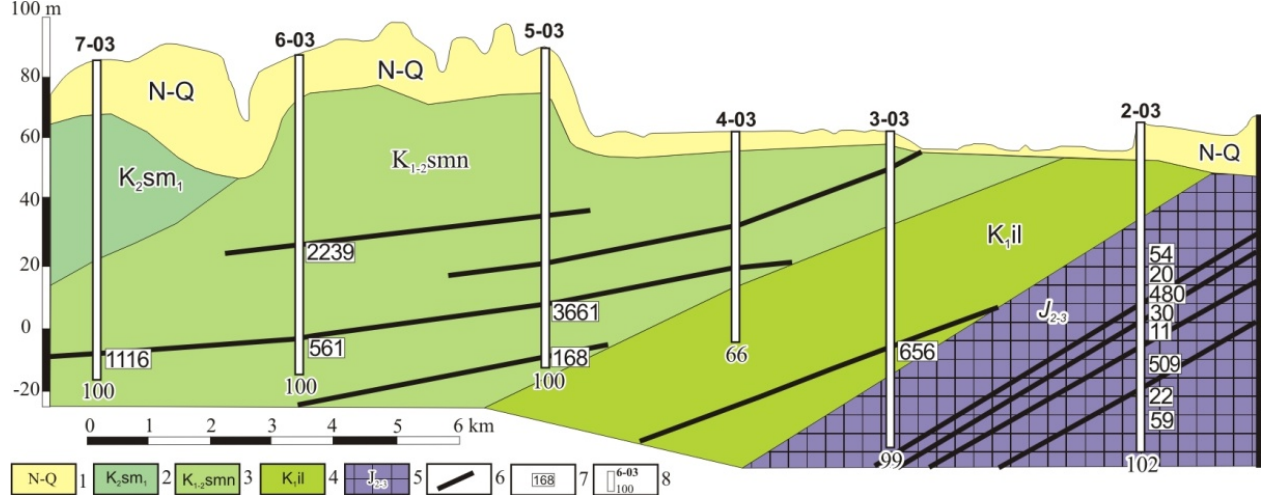
Figure 4. Schematic geological section of the lignite-bearing deposits along the Kas River [41]. Note: 1—Neogene–Quaternary undifferentiated systems, Sand, gravel-pebble, and loam with pebble; 2—Upper Cretaceous system, Symskaya Formation, Lake-alluvial deposits, Quartz sand with bands of clay and poorly lithified sandstone, lignite; 3—Lower–Upper Cretaceous system, Albian-Cenomanian–Turonian stages, Simonovskaya Formation, Gray sand with bands of clay, siltstone, and mudstone, lignite; 4—Lower Cretaceous system, Valanginian–Barremian stages, Ilek Formation, Variegated clay and clayey sand with bands of siltstone, mudstone, sandstone, and inclusions of charred plant residue; 5—Jurassic system, middle–upper divisions, Interbedded gray sandstone, siltstone, clay with lignite seams, and inclusions of charred plant remains; 6—lignite-bearing horizons; 7—Ge content in ppm of ash; 8—exploration well: its number above, depth in meters